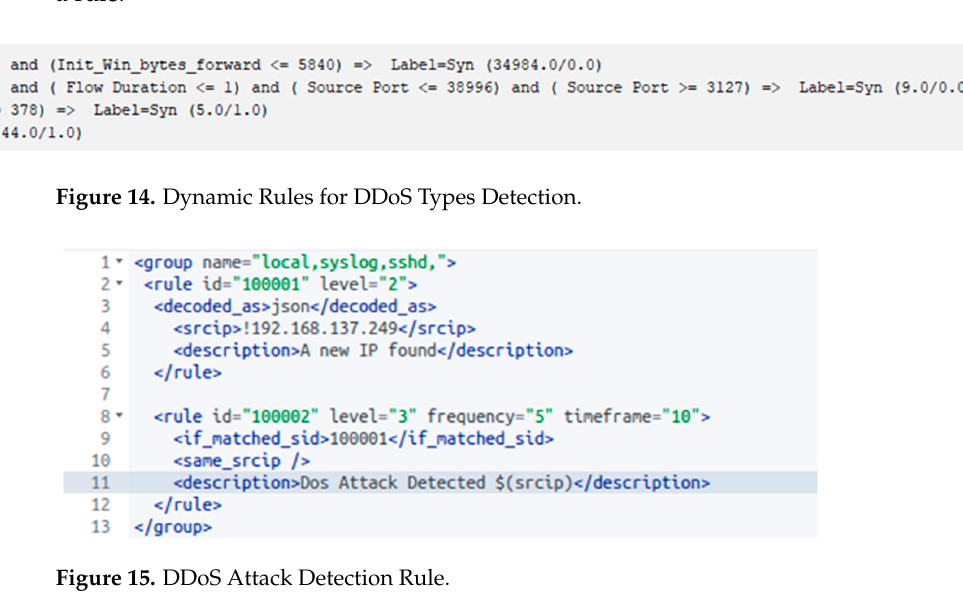
Figure 15. DDoS A tt ack Detection Rule.